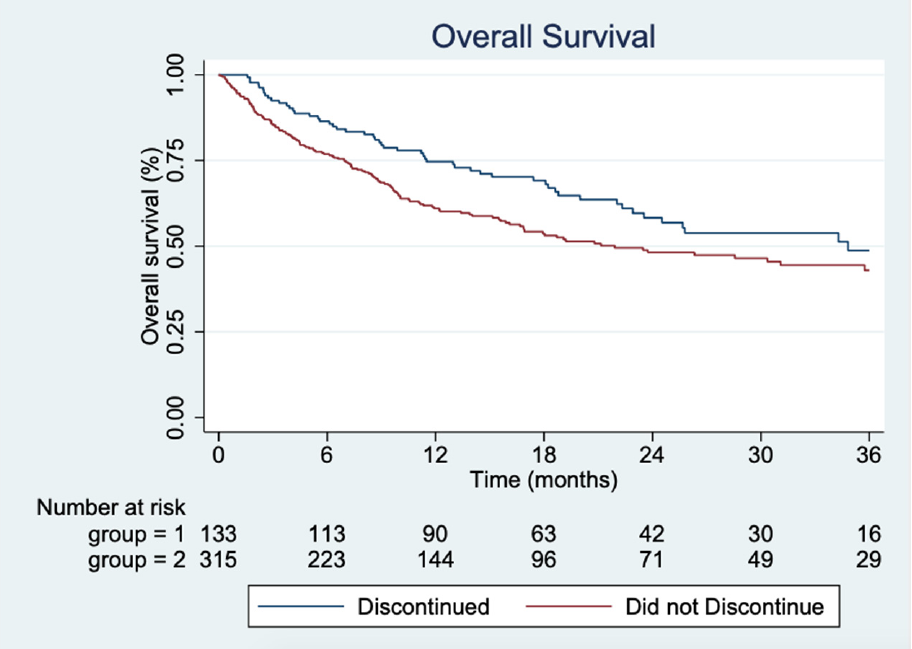
Figure 3. Kaplan–Meier plot showing the overall survival for the two groups, respectively. Univariate Cox proportional hazards models were applied on potential confounding covariates (Table 4). These showed that having a high LDH level, CRP level, cutaneous melanoma, M1a, or M1d status potentially confounded the result. Covariates Table 4. Univariate and multivariate Cox regression analyses of potential confounding factors for OS.